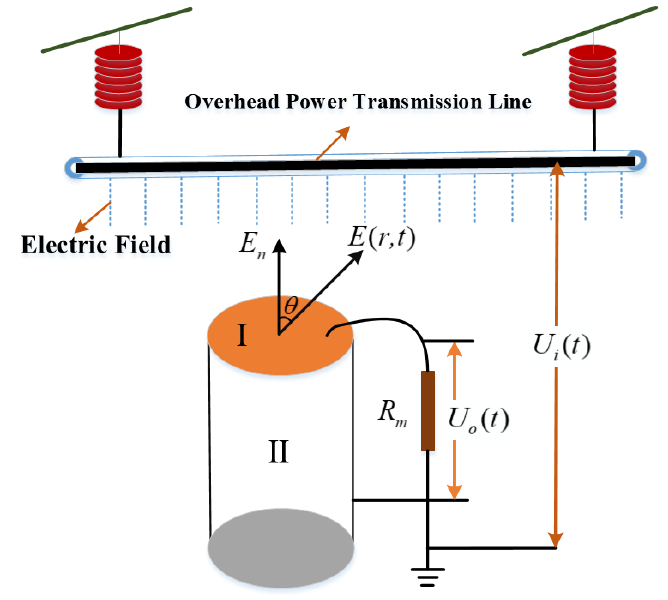
Figure 1. Measurement principle of traditional D-dot voltage sensors.